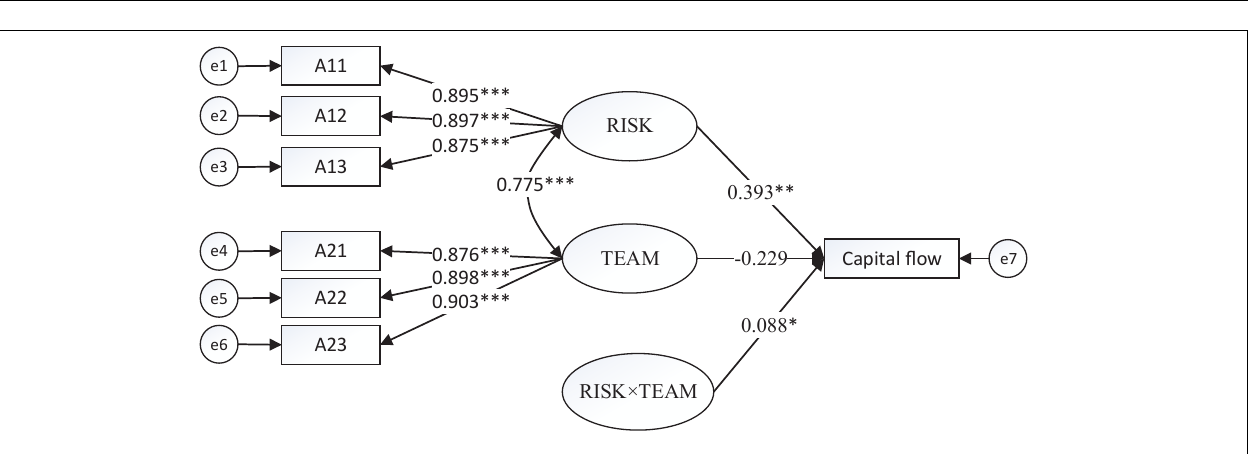
FIGURE 3 | Moderating effect of TEAM on capital flow. ∗ p < 0.05, ∗∗ p < 0.01, ∗∗∗ p <